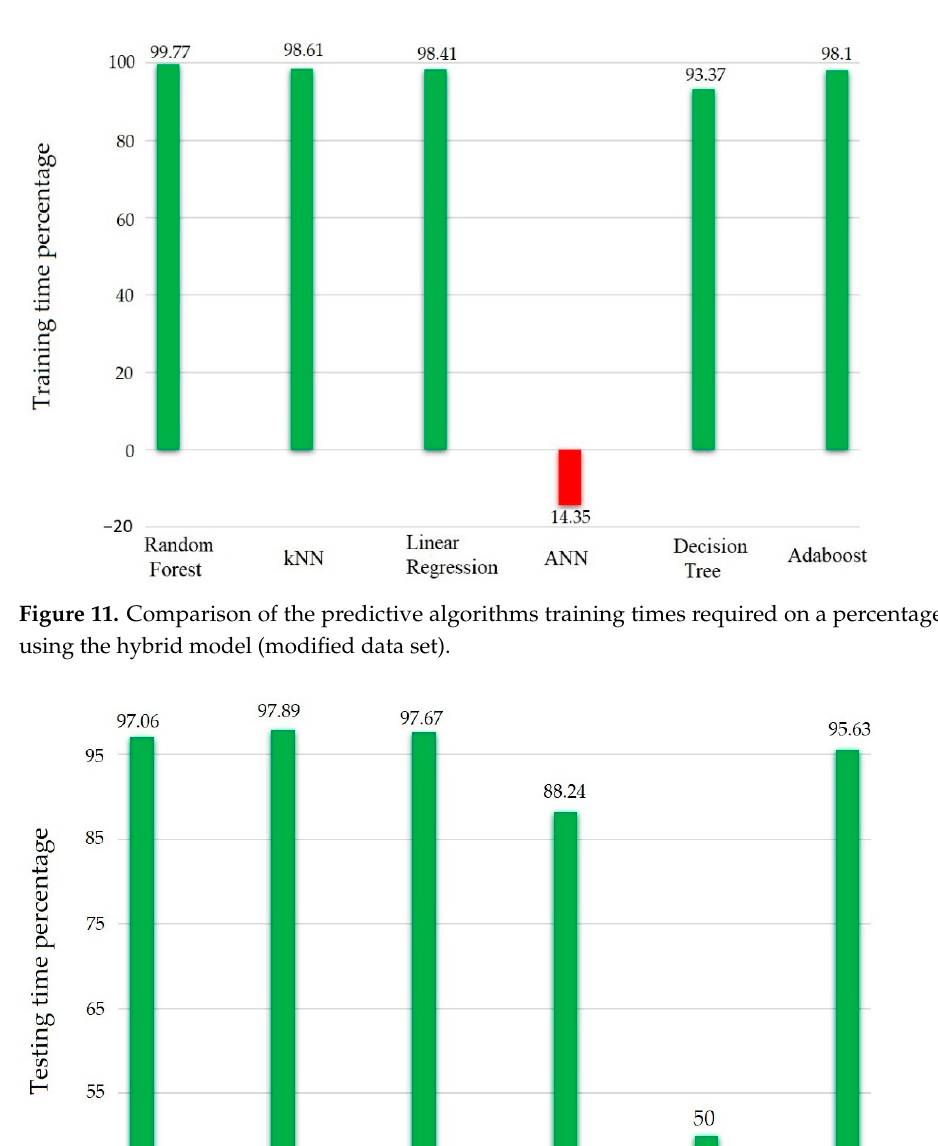
Figure 12. Comparison of the predictive algorithms testing times required on a percentage basis using the hybrid model (modified data set).